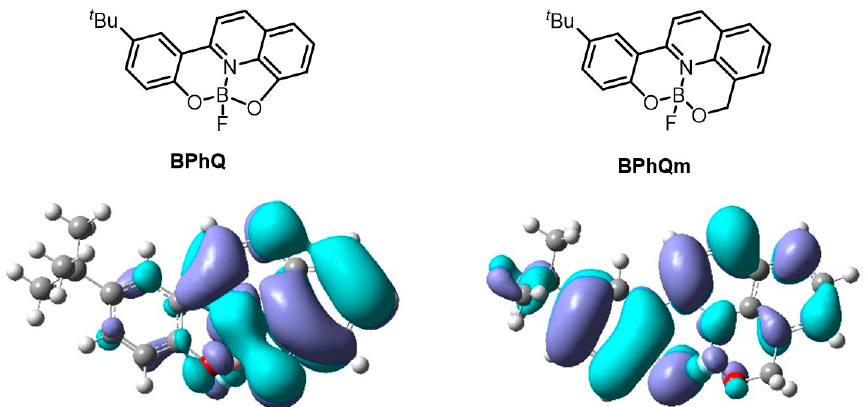
Figure 5. Transition densities ρ associated with the S 1 → S 0 excitation of ( a ) BPhQ and ( b ) BPhQm . The isosurface value for ρ is 0.0004 atomic units (purple regions: positive; blue regions: negative).